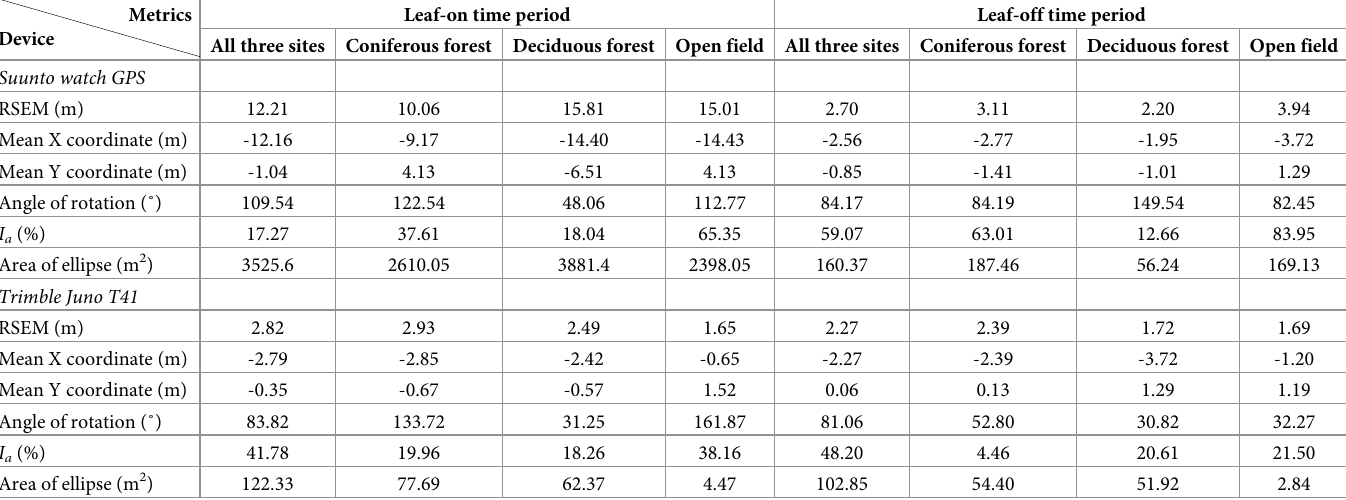
Table 1. The summary of elliptical parameters measured by different GPS equipment during different seasons (RSEM = root squared error of the mean; Mean X coordinate = the mean of difference between observed X coordinates and control X coordinate; Mean Y coordinate = the mean of difference between observed Y coordinates and control Y coordinate; I = the anisotropic a